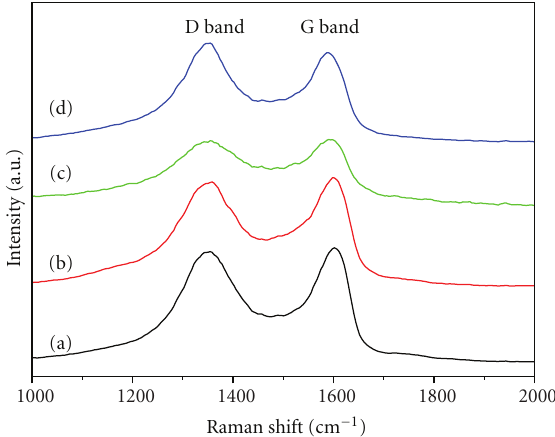
Figure 7: Raman spectrum of the R6G on (a) RGO-Au and (b) SiO 2 /Si substrate. The peaks marked by the stars ( ∗ ) and the circle dots ( • ) are the peaks of R6G and Si,